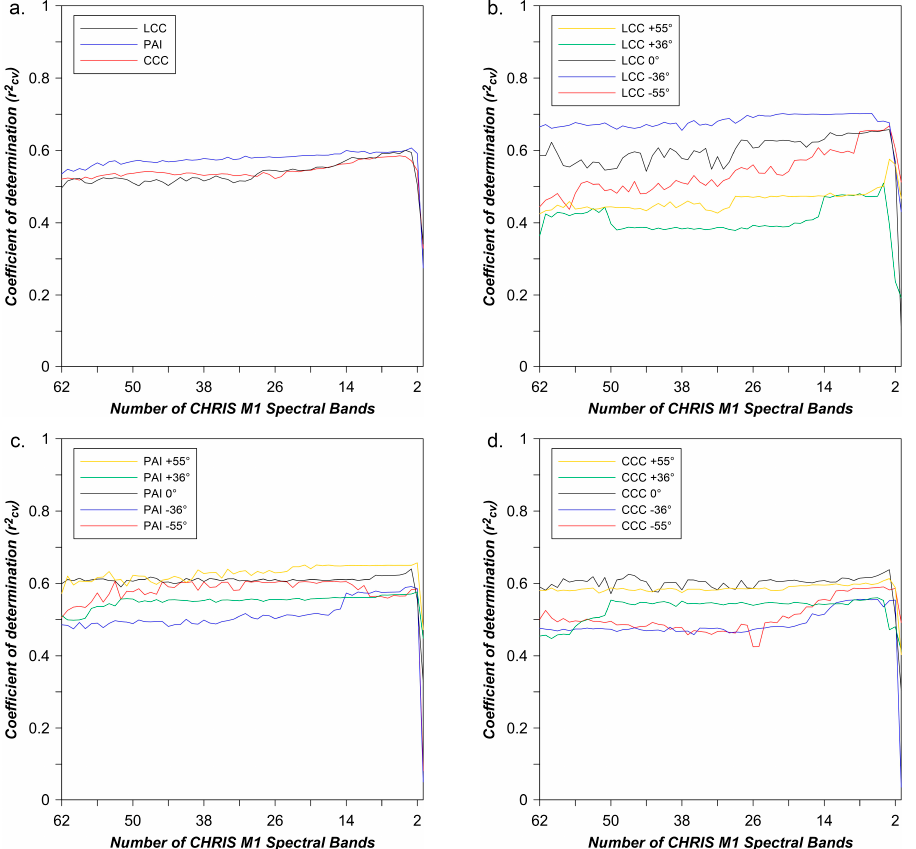
Figure 6. Gaussian processes regression (GPR) mean r 2 cv values for: ( a ) all sites and VZAs combined; ( b ) leaf chlorophyll content (LCC) over all sites and for each view angle; ( c ) plant area index (PAI) over all sites and for each view angle; and ( d ) canopy chlorophyll content (CCC) over all sites and for each view angle. Graphs demonstrate modelling results as spectral bands are removed from the optimized GPR model. Results improved as bands were removed; optimal models typically contained 3 to 4 spectral features (i.e., predictor variables). The 0° view zenith angle (VZA) produced the best overall modelling results when variables were averaged. PAI model fits were typically highest and most consistent as predictor variables were iteratively removed from the GPR